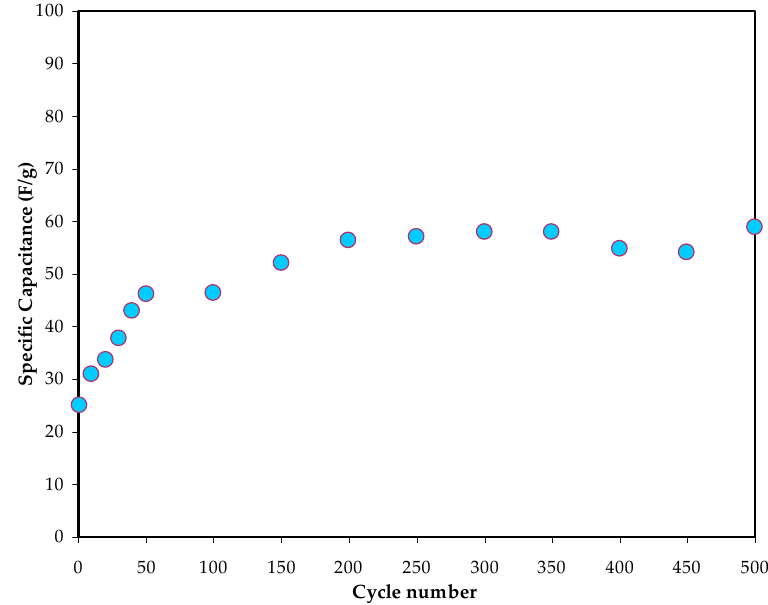
Figure 16. Variation in C s value during 500 cycles.